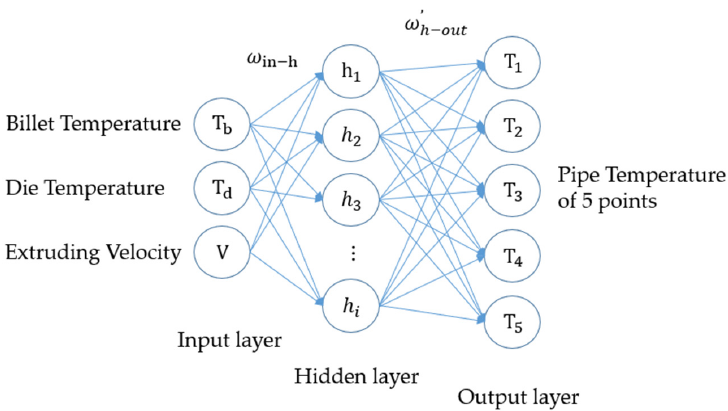
Figure 11. Neural network structure.